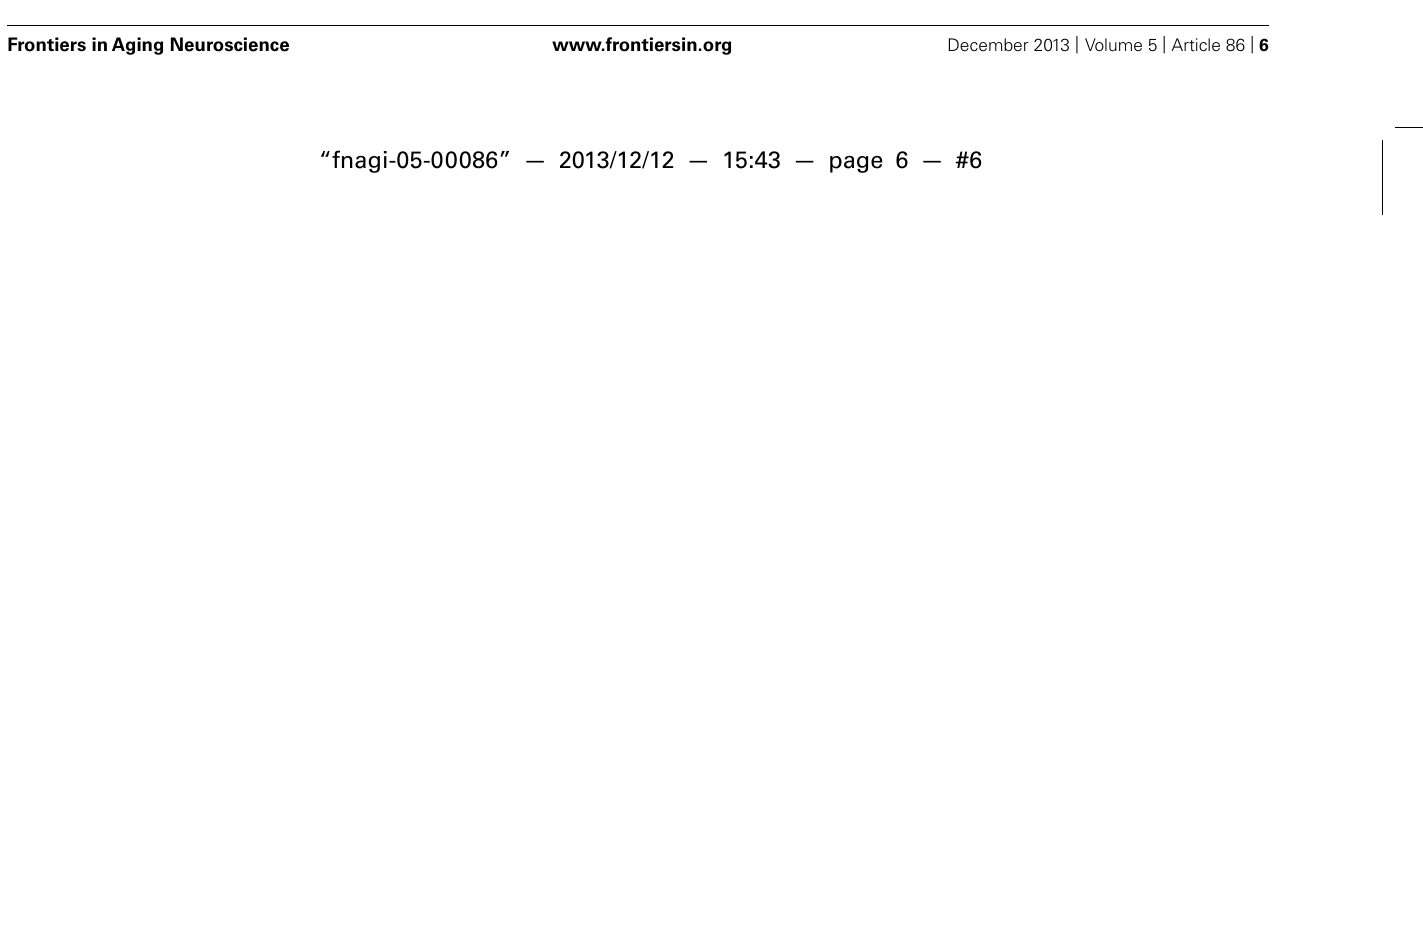
extent by the hippocampus and other corticocortical interactions (Moretti et al.,